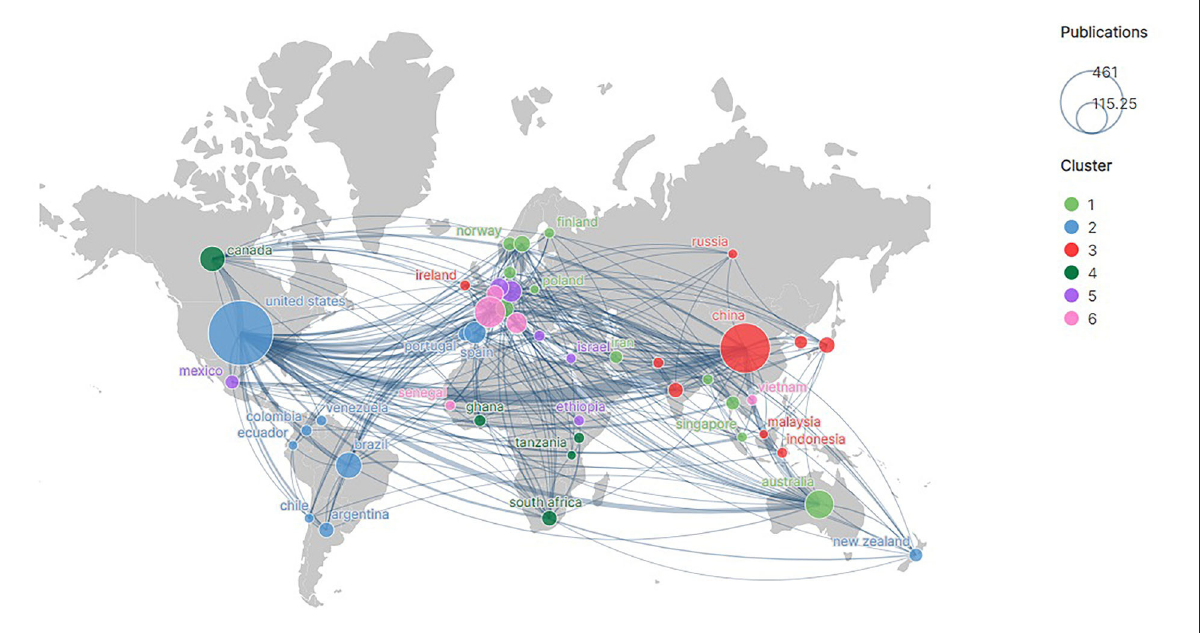
factors) factors on the prevalence patterns of the infectious diseases (RD_2; macro). However, scholars from the USA and England have produced more publications that Chinese scholars regarding the direction of the causes of infectious disease epidemics at the micro-scale (virus/bacterial genetics and mutation) (RD_2; micro) and the simulated dynamics of infectious disease transmissions